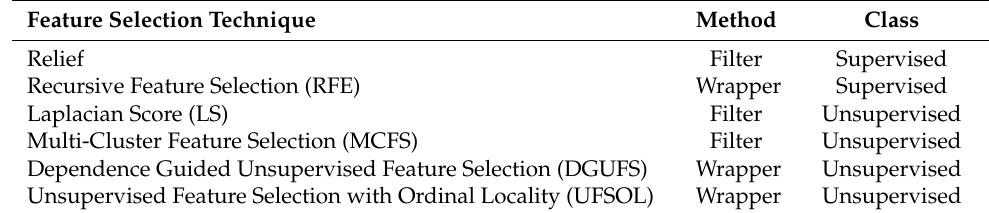
Table 2. Feature selection